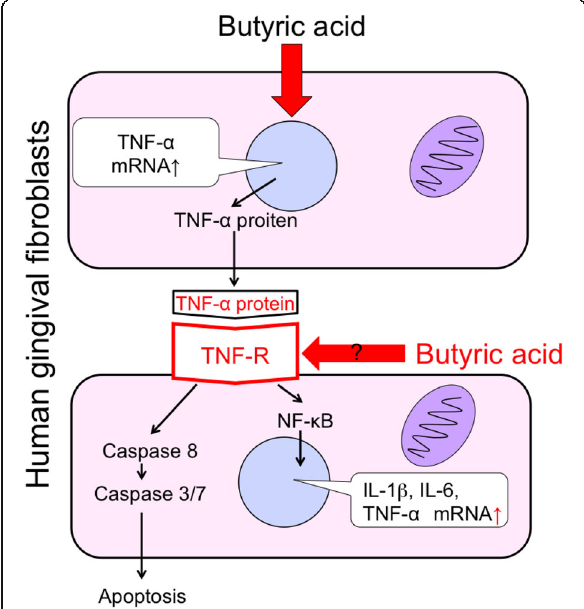
Fig. 2 Butyric acid may alter the TNF-R of HGFs. Adopted